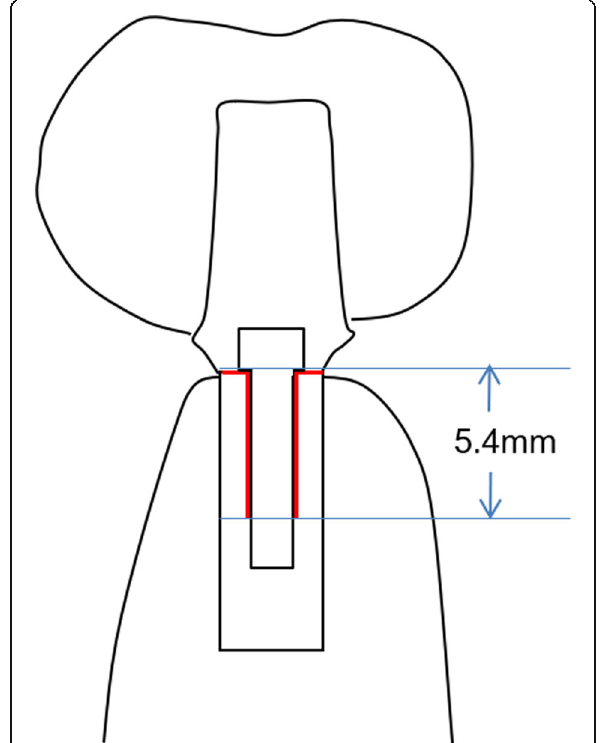
Fig. 5 The range of the slip boundary